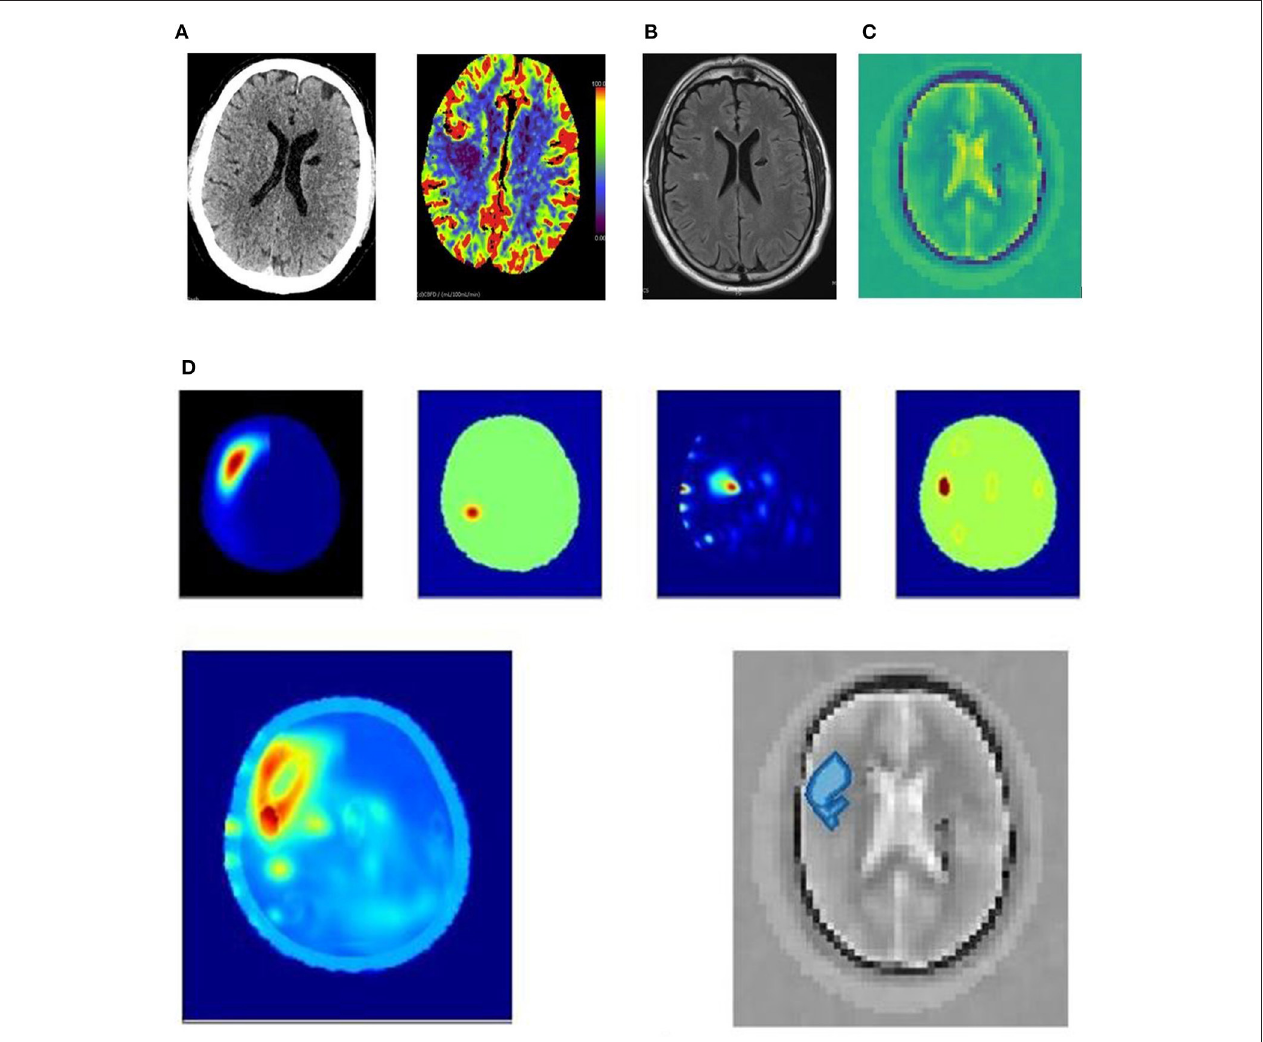
FIGURE 3 | (A–D) 63yo patient with an ischemic stroke right middle cerebral artery distribution. (A) 63yo patient with an ischemic stroke right middle cerebral artery distribution. CT 3 hrs after onset of left hand weakness. The plain CT shows no acute abnormality; however, the cerebral blood flow perfusion scan (units ml/100 ml/minute cerebral blood flow for perfusion colormap) shows decreased blood flow in right middle lobe. (B) 63yo patient with an ischemic stroke right middle cerebral artery distribution. MRI T2 FLAIR sequence shows small area of diffusion restriction at 24h after symptom onset, and after almost complete resolution of symptoms. (C) 63yo patient with an ischemic stroke right middle cerebral artery distribution. Dielectric permittivity map from an electromagnetic scan performed at 21h after symptom onset. (D) 63yo patient with an ischemic stroke right middle cerebral artery distribution. Examples of processing algorithm using radar-based frequency domain and time domain signal analysis, signal asymmetry, tomography and direct mapping. The algorithm outputs are fused into a representative image for localization. An artificial intelligence algorithm classifies haemorrhagic stroke with a red color code, while ischaemic stroke is color-coded as blue, and this is overlaid on a greyscale permittivity